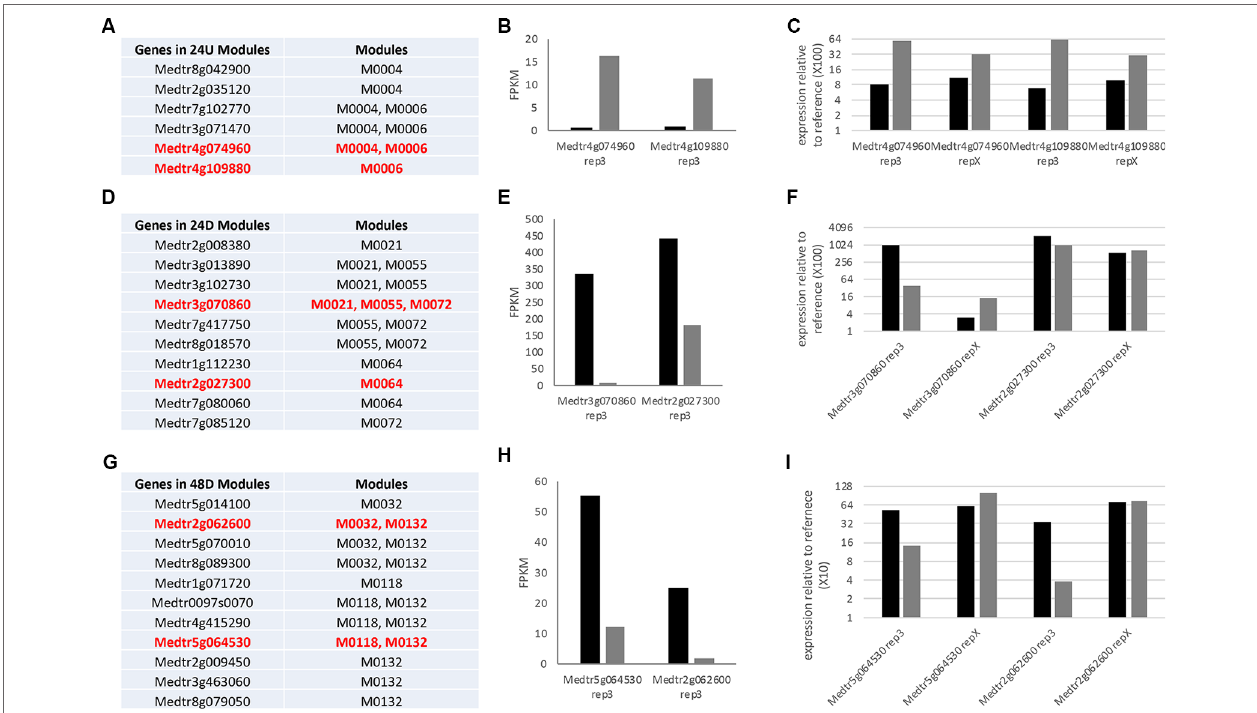
FIGURE 5 | Investigation of module gene expression prediction. (A , D , G) List of genes contained in modules grouped in the text as composed completely of genes differentially expressed at one time point. Genes in red were used for further analysis here because they are not described in the text and they had similar expression levels aiding analysis. (B , E , h) Graph of the expression (fragments per kilobase of gene per million read pairs) of the genes in red in replicate 3 of the RNA-Seq. (C , F , I) Results of real time qRT-PCR analysis of expression of these genes in replicate 3 and an additional identical replicate x at the time point in question, displayed as relative expression to aid comparison. See Methods for primers and normalization calculation.